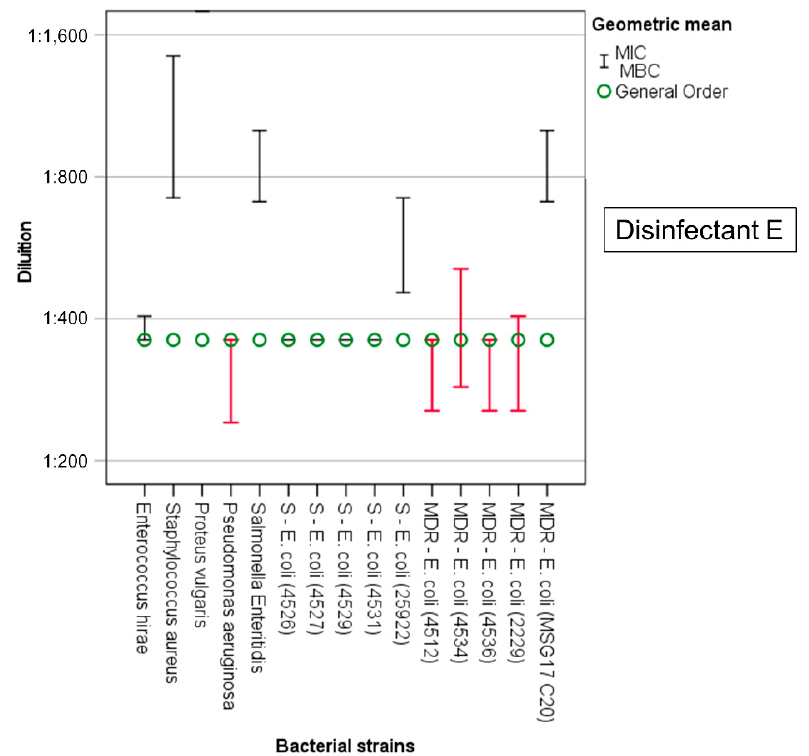
Figure 3. Disinfectant E. Minimum inhibitory concentration (MIC, upper whisker) and minimum bactericidal concentration (MBC, lower whisker). In red, bacterial strains tolerant to disinfectants (MBC > GO).